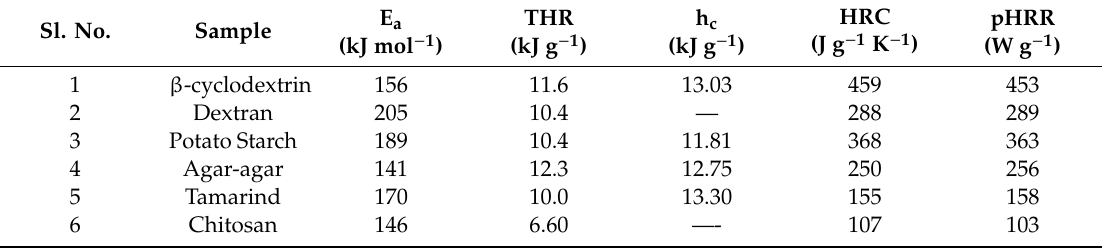
Table 6. Energy of activation and some relevant parameters from PCFC